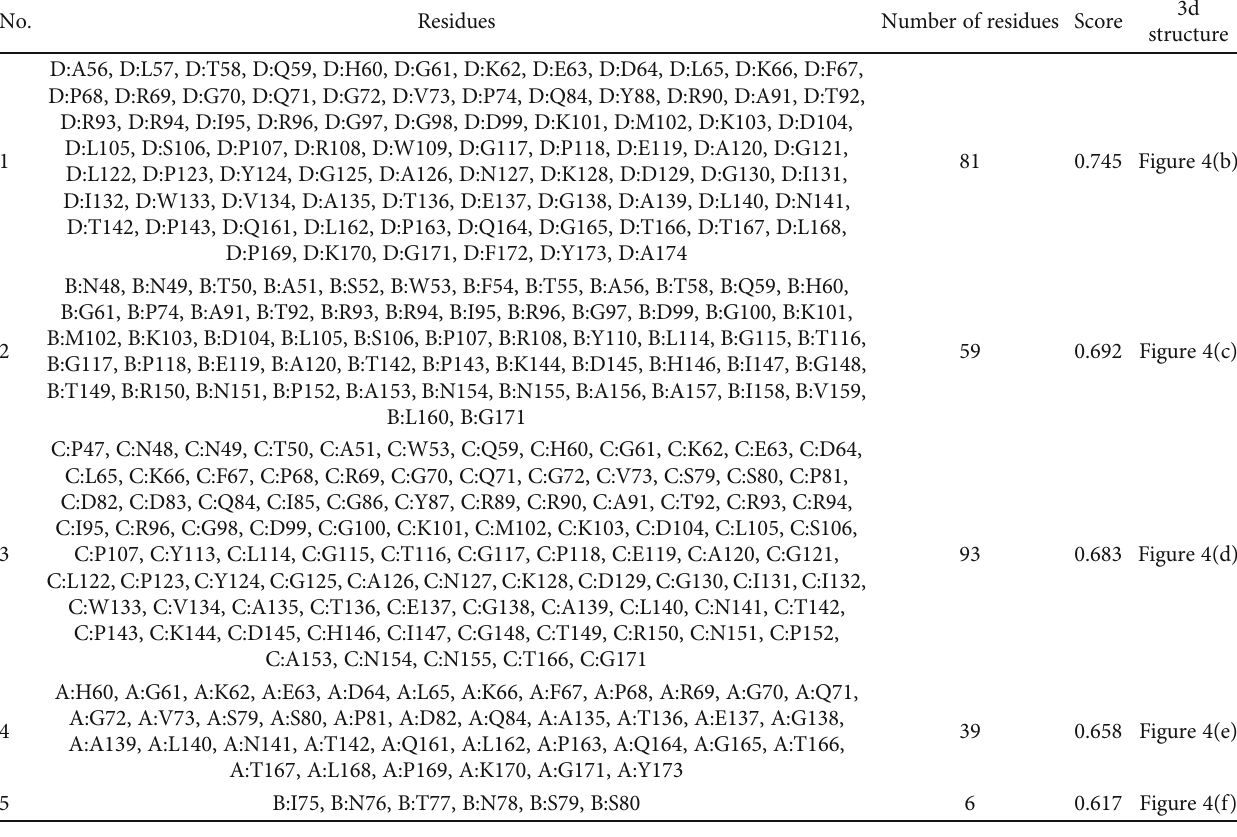
Table 2: The B cell discontinuous epitopes of the SARS-CoV-2 nucleocapsid phosphoprotein. No. Residues